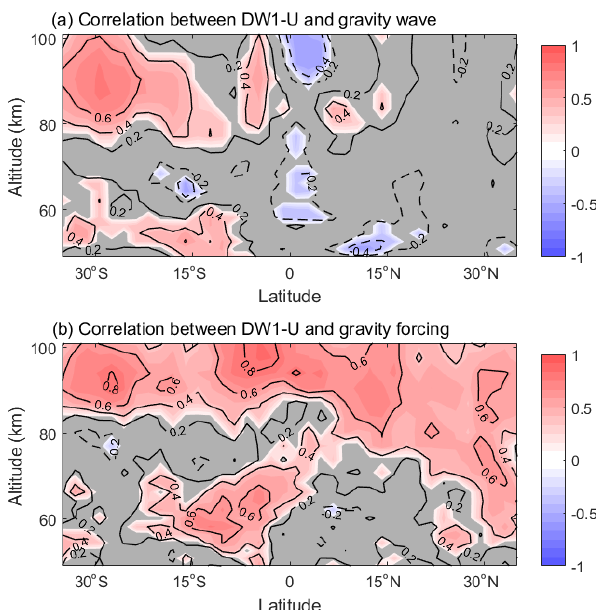
Figure 8. Correlation (a) between DW1-U and GW drag, (b) be- tween DW1 U and GW forcing from 1979 to 2014 winter (DJF). Solid lines and red shadings denote the positive responses, while dashed lines and blue shadings denote the negative responses; the grey regions indicate where the response is insignificant at the 95% level according to the F